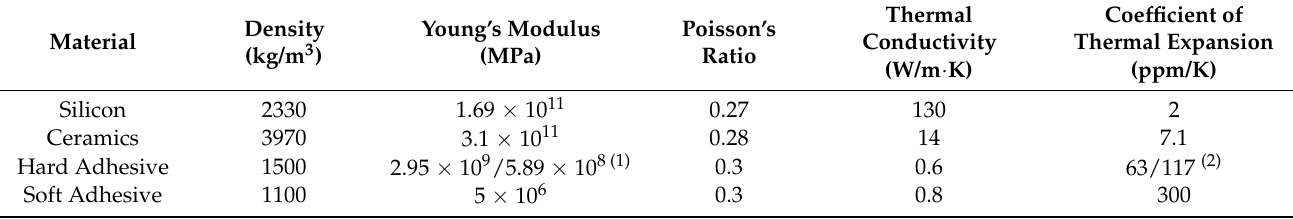
Table 1. The material parameters applied in the calculation.